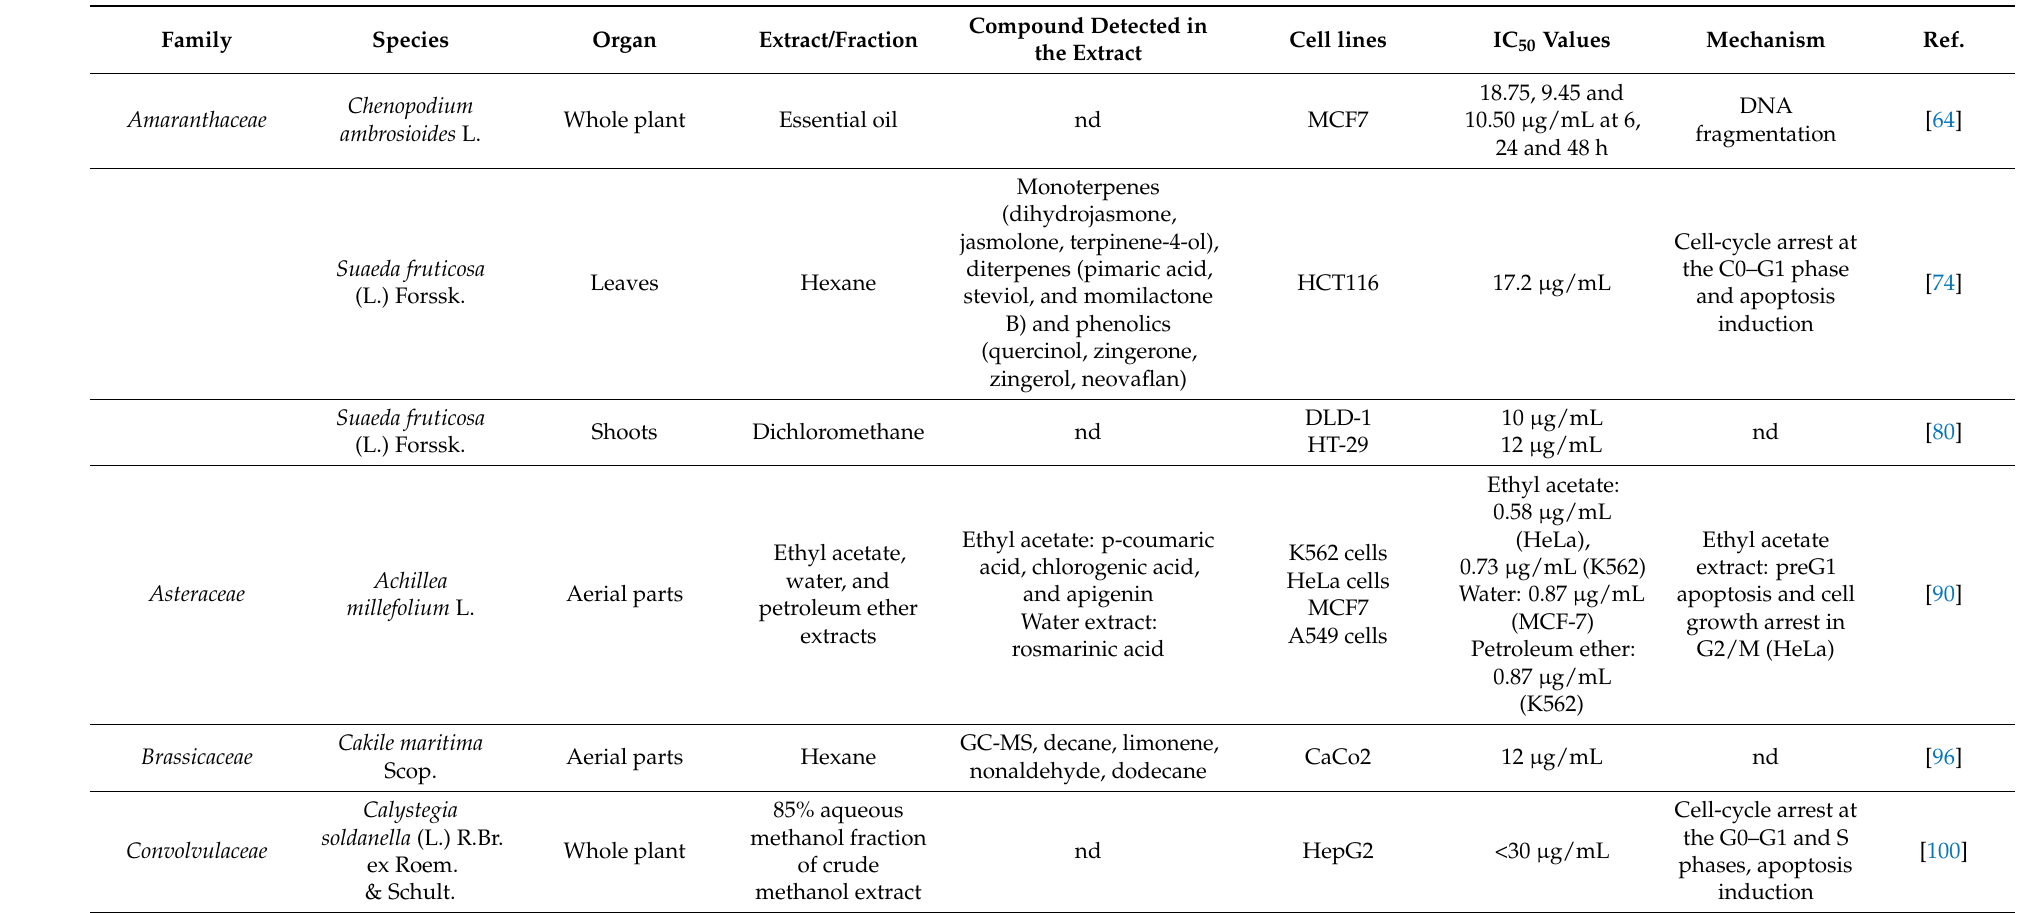
Table 3. Cytotoxic activity of selected halophytes species, including types of extracts, compounds, cell lines tested, obtained IC 50 values, and proposed mechanisms of action. The criterion of cytotoxic activity for the crude extracts, as established by the American National Cancer Institute (NCI), was considered as an IC 50 < 30 µ g/mL upon 48 h or 72 h of incubation